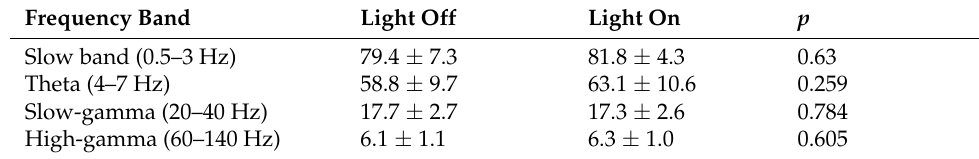
Table 2. Changes induced by light in hippocampal LFP rhythms under ACh receptors blockade. Frequency Band Light Off Light On